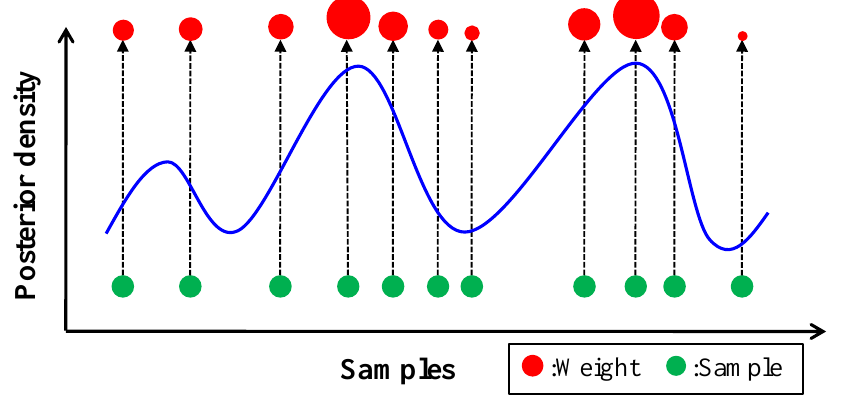
Figure 4. The approximation of the posterior density by the random samplings.